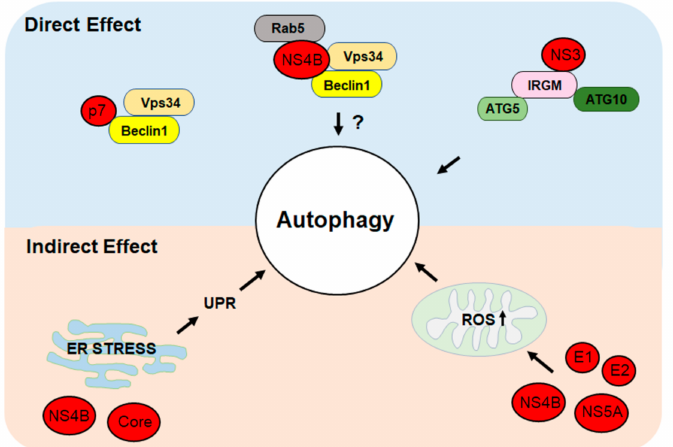
Figure 1. Direct and indirect mechanisms of hepatitis C virus (HCV)-induced autophagy. HCV proteins can directly induce autophagy by interacting with cellular proteins that regulate autophagy. HCV can also indirectly induce autophagy by inducing the ER stress to trigger the unfolded protein response (UPR) or by inducing the production of reactive oxygen species (ROS) and oxidative stress. See text for